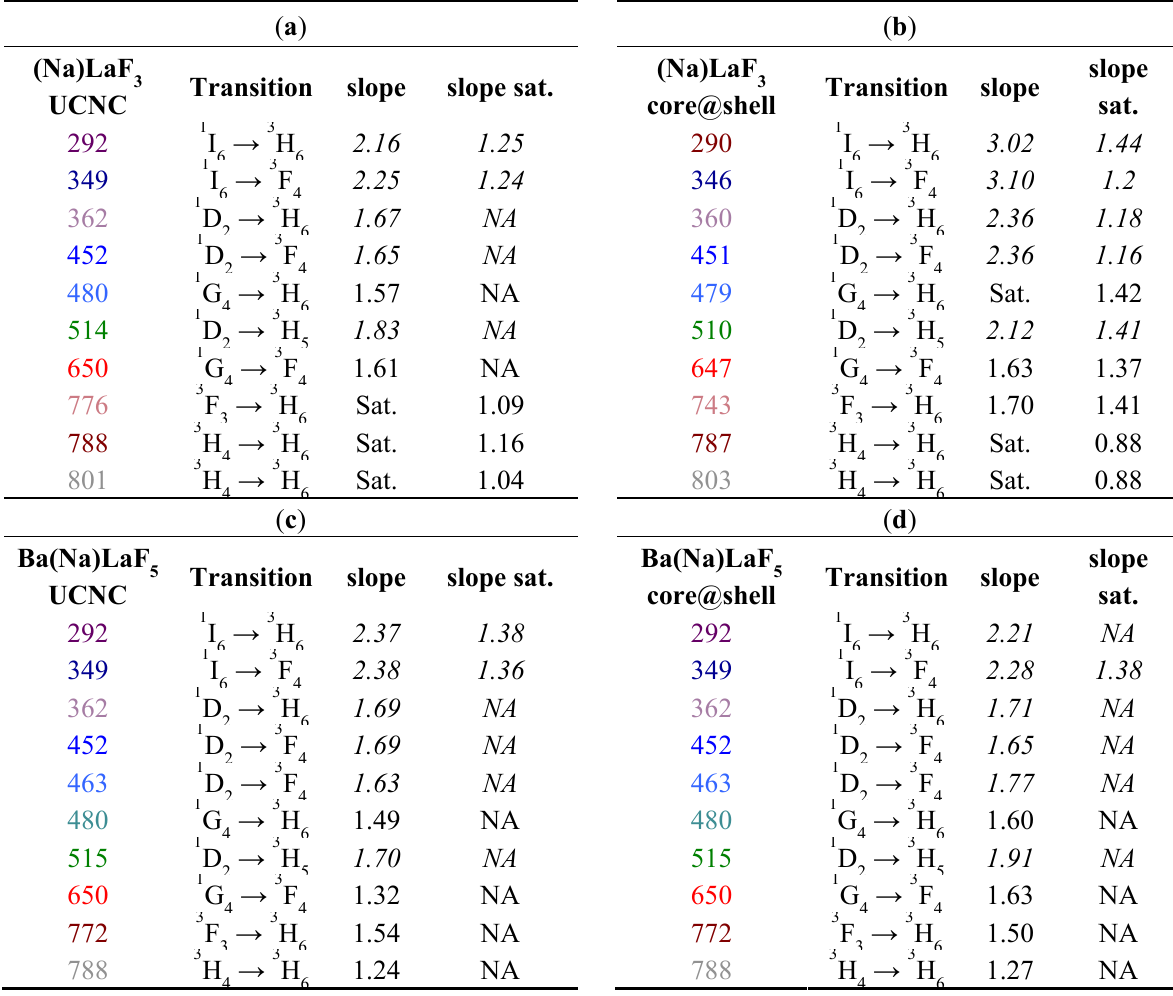
Table 4. Emission intensity vs . 980 nm laser power density (W/cm 2 ), ln-ln IvP plotted UCNC; ( b ) (Na)LaF core@shell; linear slopes of 0.5%Tm, 20%Yb codoped ( a ) (Na)LaF 3 3 ( c ) Ba(Na)LaF UCNC; and ( d ) Ba(Na)LaF core@shell; emission bands and transitions, 5 5 ln-ln IvP slopes per radiative transition at low laser density, and slopes at saturation are given. Slopes in bold , italics , and plain text correspond to matched Tm states of origin. NA denotes state saturation Not